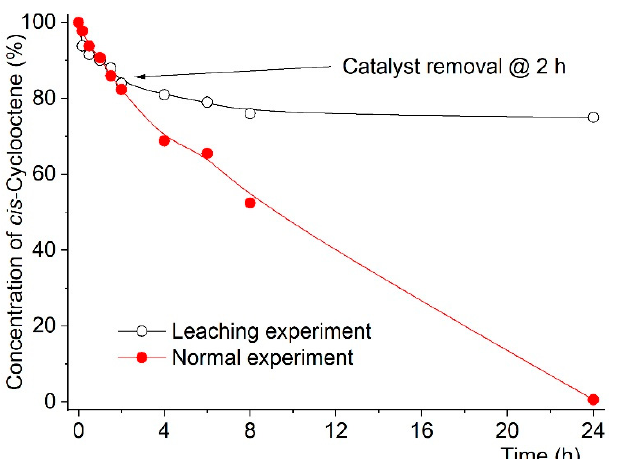
Figure 8. Leaching experiment reaction kinetics of substrate consumption in toluene at 353 K for cis -cyclooctene epoxidation in the presence of MNP 30 -Si us -phos-Mo catalyst. In the leaching experiment the catalyst was removed after 2 h reaction time. Efficiency of the catalysts was also evaluated by changing the amount of oxidant, tert - butylhydroperoxide (tbhp), from 200 mol% relatively to olefin, as described in literature [37,38], down to 150 and 100 mol%, i.e., till reaching stoichiometric oxidant/substrate ratio. Catalyst’s efficiency was tested for cis- cyclooctene and R -(+)-limonene epoxidation at 353 K and 383 K with toluene as solvent (Table 4). These reaction conditions were chosen considering the good performance of catalysts as shown in Tables 1 and 2. For cis- cyclooctene epoxidation, all systems performed at their best when the tbhp ratio was set to 200 mol%. Although product selectivity towards the epoxide product was not affected the substrate conversion level vs. tbhp ratio was found to vary drastically only for some cases (Table 4, entries 3 and 5). Table 4. c is- Cyclooctene and R -(+)-limonene epoxidation with different amounts of oxidant, tert -butylhydroperoxide (tbhp), in toluene and in the presence of catalysts MNP 11 -Si-phos-Mo , MNP 30 -Si-phos-Mo, and MNP 30 -Si us -phos-Mo . Entry Reaction [a] Catalyst Temp. (K)